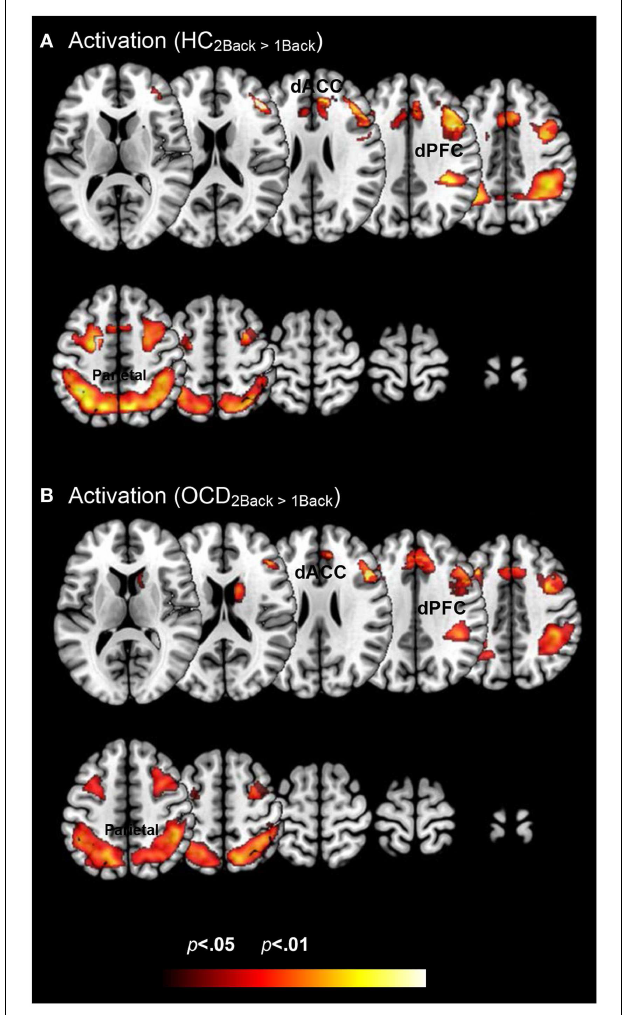
FIGURE 2 |Within group changes in activation profiles as a function of load are depicted on identical ascending mosaics of axial views .The significant clusters ( p < 0.05, cluster level) show significant increases in activation with increases in working memory related load. As seen, these increases are evident within both (A) healthy control and (B) OCD groups. These activation profiles establish within group effects of memory load across previously implicated load sensitive working memory related regions.These include dorsolateral prefrontal cortex (dPFC), the dorsal anterior cingulate (dACC), and the parietal